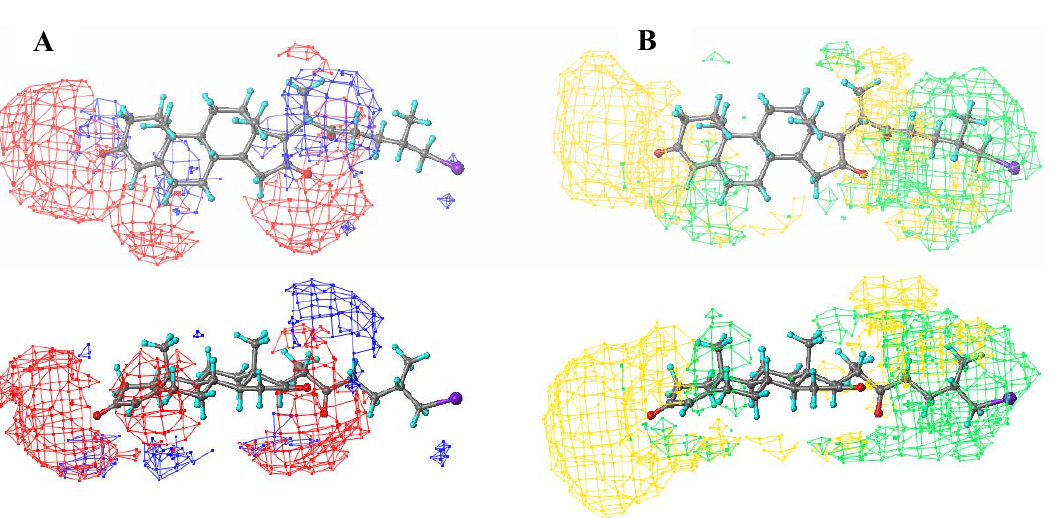
Figure 3. Electrostatic and steric contours mapped onto compound 15